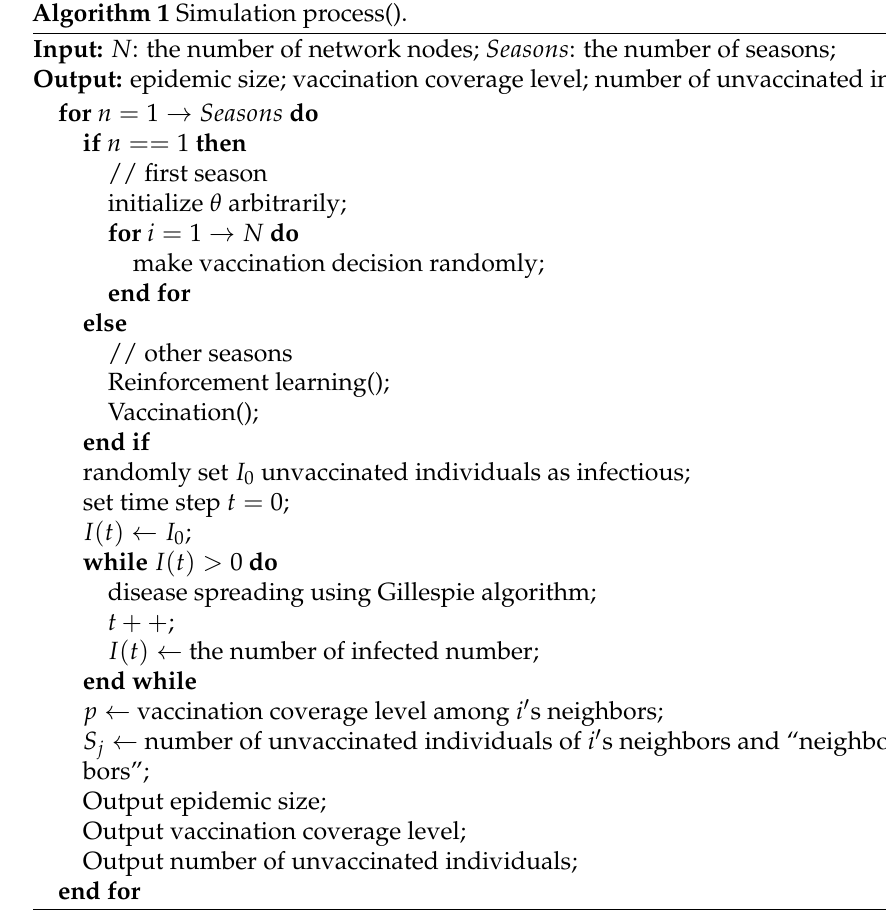
Algorithm 1 Simulation